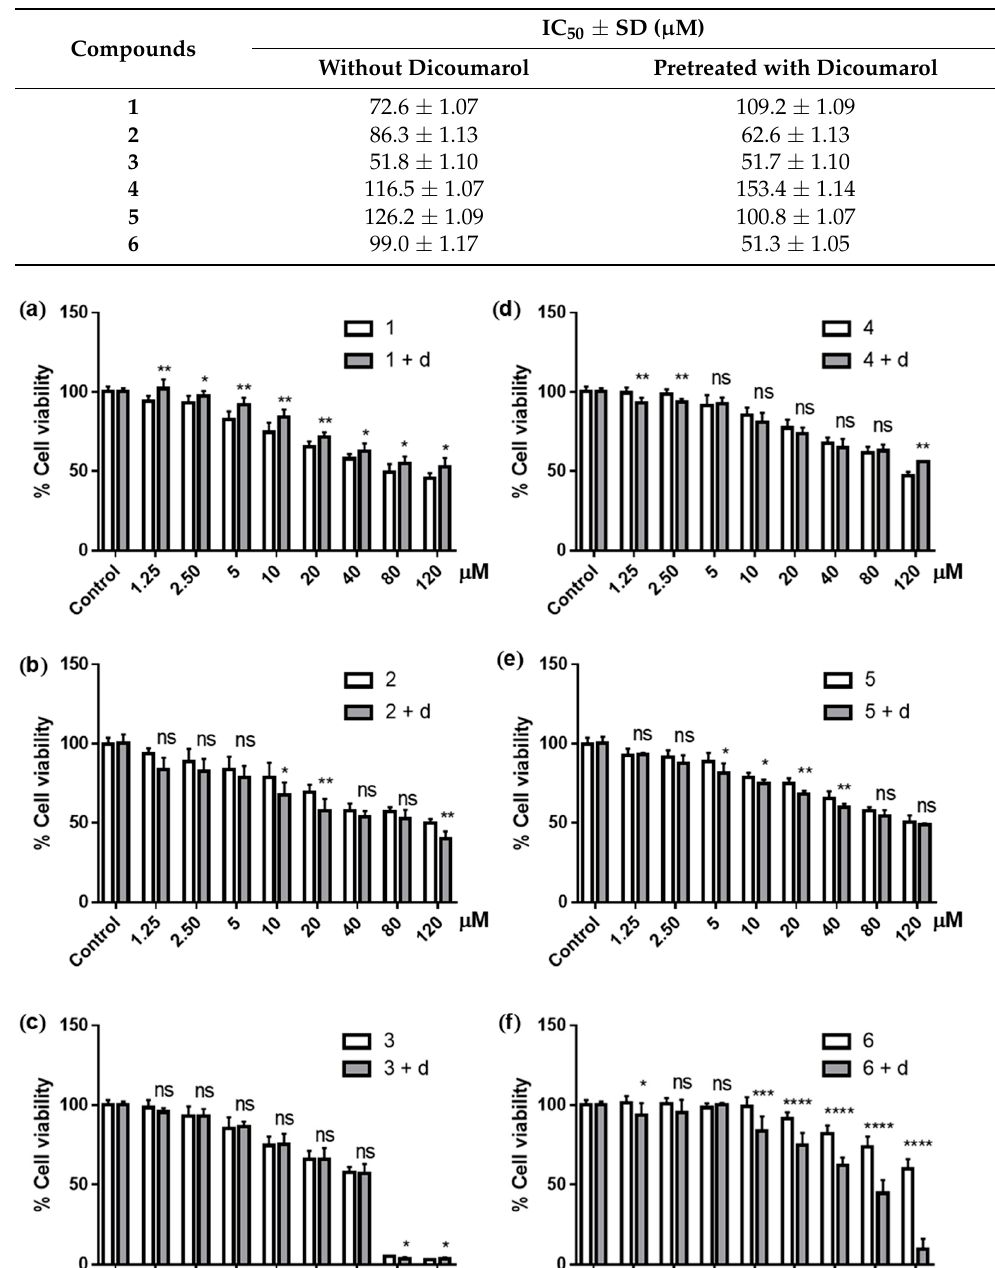
Table 2. Cytotoxic activity of compounds 1 - 6 against PC3 prostate cancer cells (pretreated vs. untreated with 10 µ M dicoumarol; SRB assay).